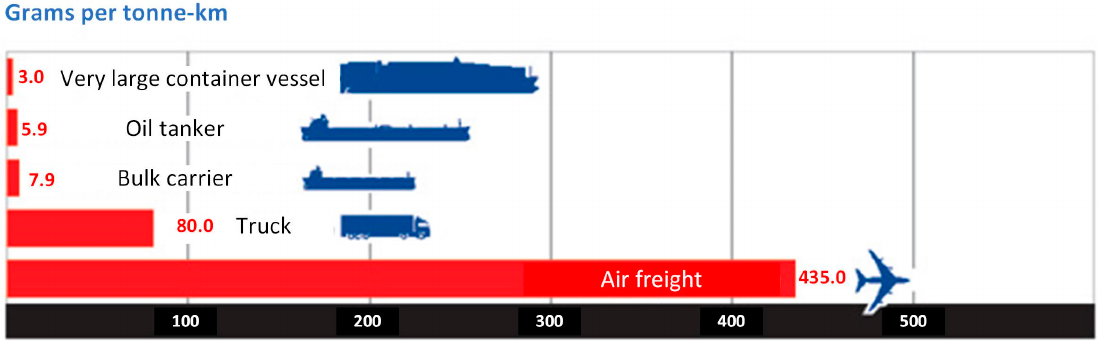
Figure 16. CO 2 emissions for different types of transport, source [23].